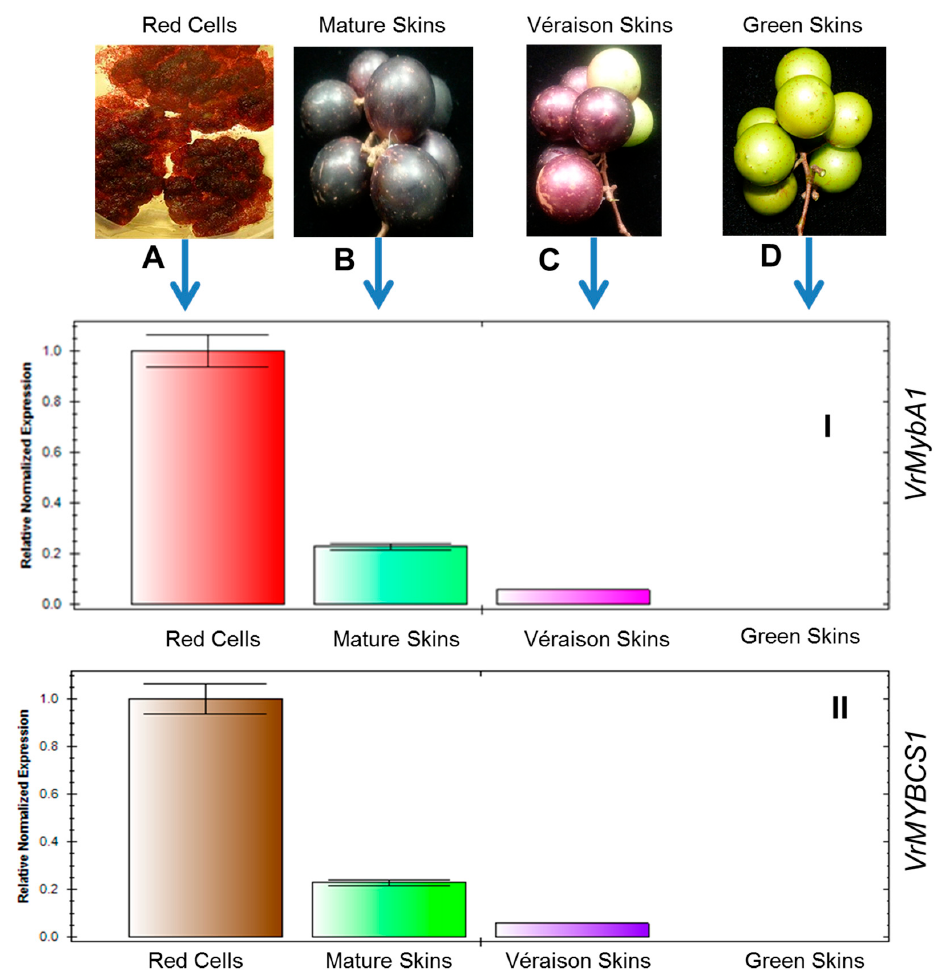
Figure 6. Plant samples used in the experiment ( A ) (Red cells); ( B ) (Mature berries); ( C ) (Veràison berries); and ( D ) (Green berries) and mRNA expression levels of VrMybA1 ( I ); and VrMYBCS-1 ( II ) genes in different developmental stages of muscadine grape berry skins. The values are expressed relative to a level of transcription ( I ) the veràison, which was set as 0.1. Values are the means of three replicates ± SE.